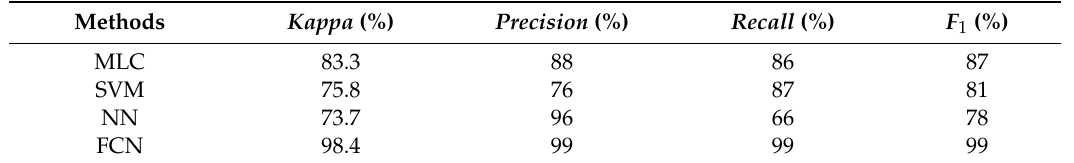
Table 3. Precision comparison of MLC, SVM, NN, and FCN.